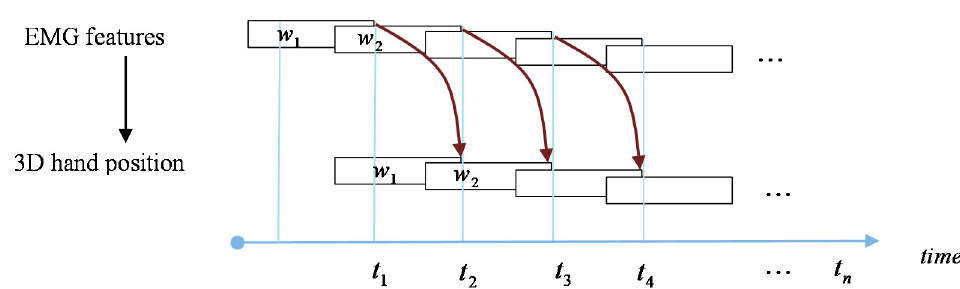
Figure 9. The mapping of EMG features to 3D hand position. The EMG features which are repre ‐ sented with window length 𝑤 (cid:3036) at time 𝑡 (cid:3036) are mapped to the 3 ‐ D hand position at 𝑡 (cid:3036)(cid:2878)(cid:2869) . with window length w i at time t i are mapped to the 3-D hand position at t i + 1